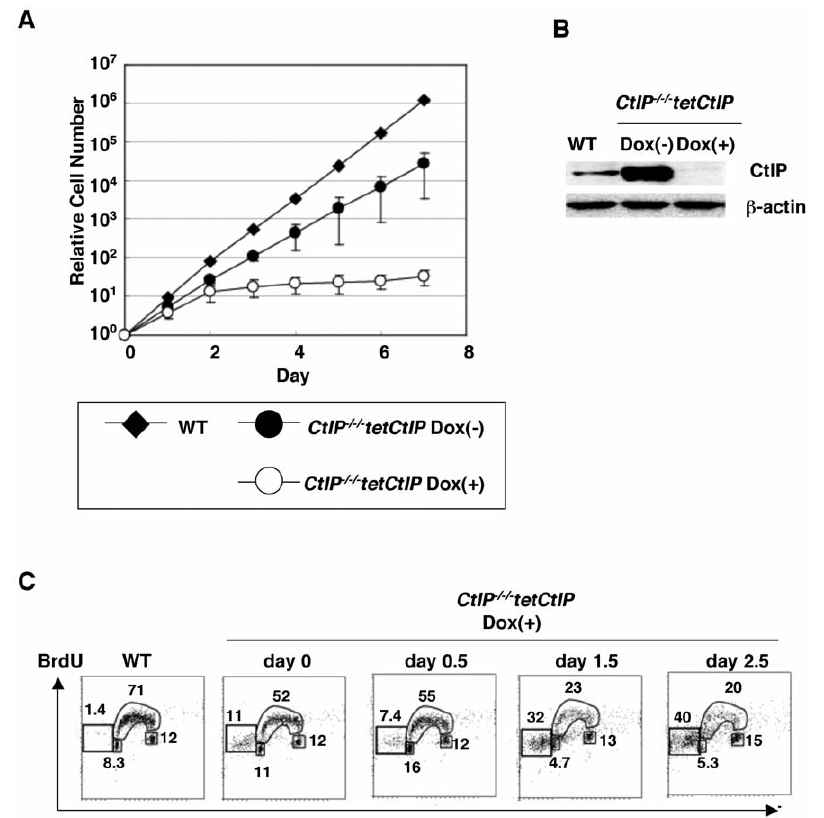
Figure 1. CtIP is essential for cell survival. (A) Defective proliferation of CtIP 2 / 2 / 2 tetCtIP cells following addition of doxycycline (2 m g/ml) to deplete CtIP, from time zero. Data shown are the average results from three separate clones. Points indicate mean (n=3); bars indicate S.D. (B) Western blot analysis of chicken CtIP expression. Whole cell lysates were prepared from CtIP 2 / 2 / 2 tetCtIP cells 24 h after addition of doxycycline. b - actin was used as a loading control. (C) Cell cycle distribution of CtIP 2 / 2 / 2 tetCtIP cells at the indicated time after addition of doxycycline. Cells were pulse-labeled with BrdU for 10 min and subsequently stained with FITC-conjugated anti-BrdU antibody (Y axis, log scale) and propidium iodide (PI) (X axis, linear scale). Each square on the left-hand side represents apoptic cells (sub-G 1 fraction). The small rectangle at the bottom of the tubular arch, the tubular arch, and the small square to the right represent cells in the G 1 , S, and G 2 /M phases, respectively.